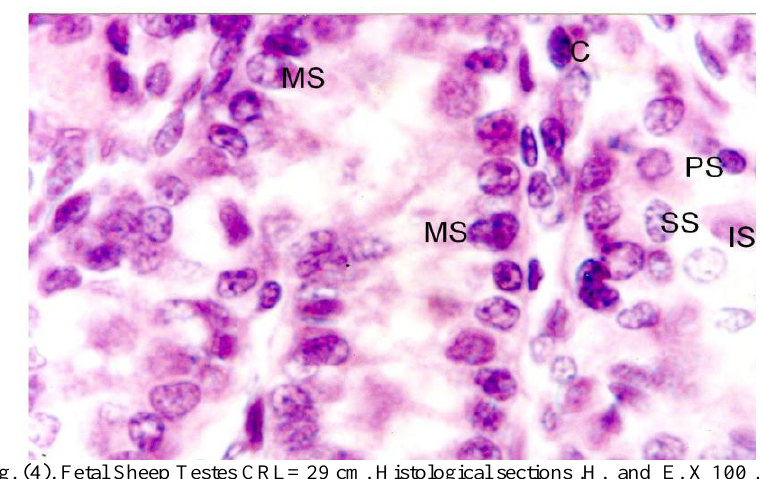
Fig. (3) . Fetal Sheep Testes CRL = 19cm . H and E. X 100. D= Spermatogonium cells SS= Secondary spermatocyte SC= Mature Sertoli Cell PS= Primary